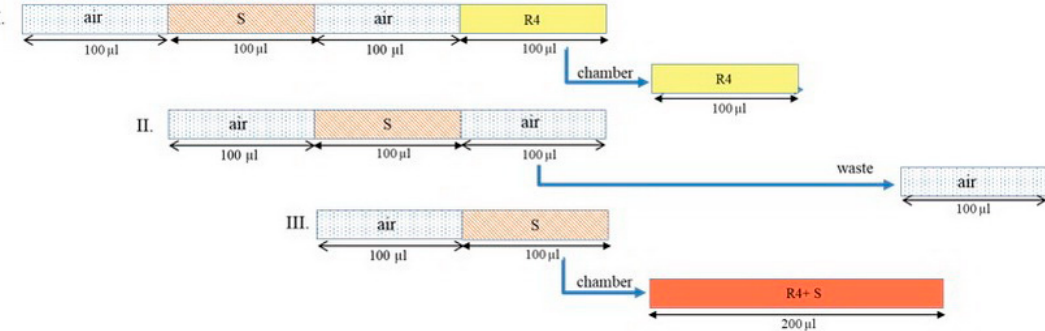
Figure 3. A sequence profile for creatinine determination (R4: Mixed reagent for creatinine determination (R4: 0.025 mol·L –1 sodium picrate, 0.75% NaOH, 0.03 mol·L –1 KH 2 PO 4 ), S: Pretreated creatinine solution).